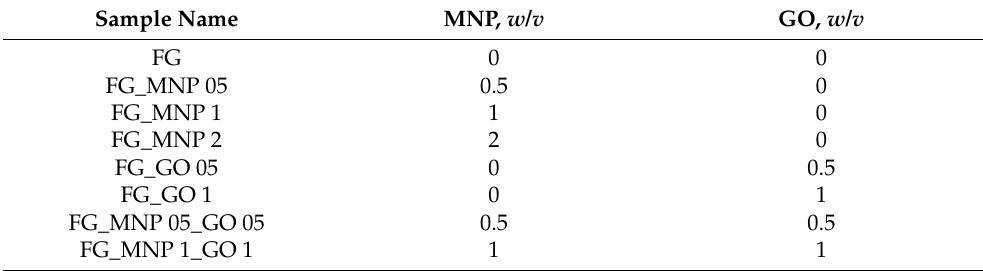
Table 3. Detailed formulations of the precursor compositions (protein concentration was 50% w / v in all